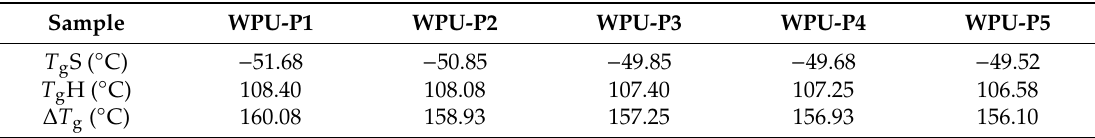
Table 2. T g of WPU-P films with different PCLD contents.